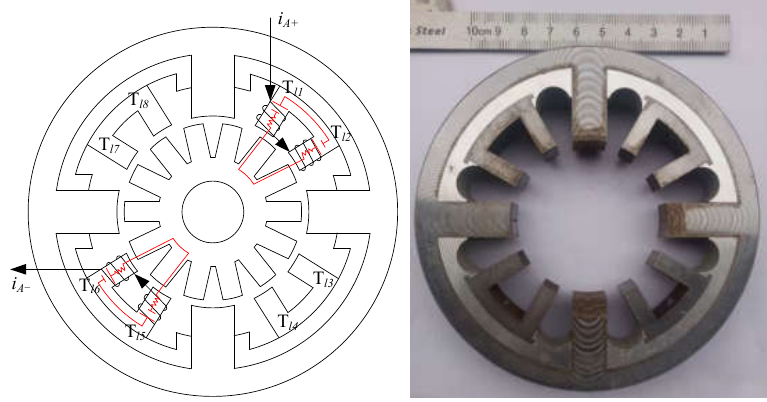
Figure 1. The structure and prototype.